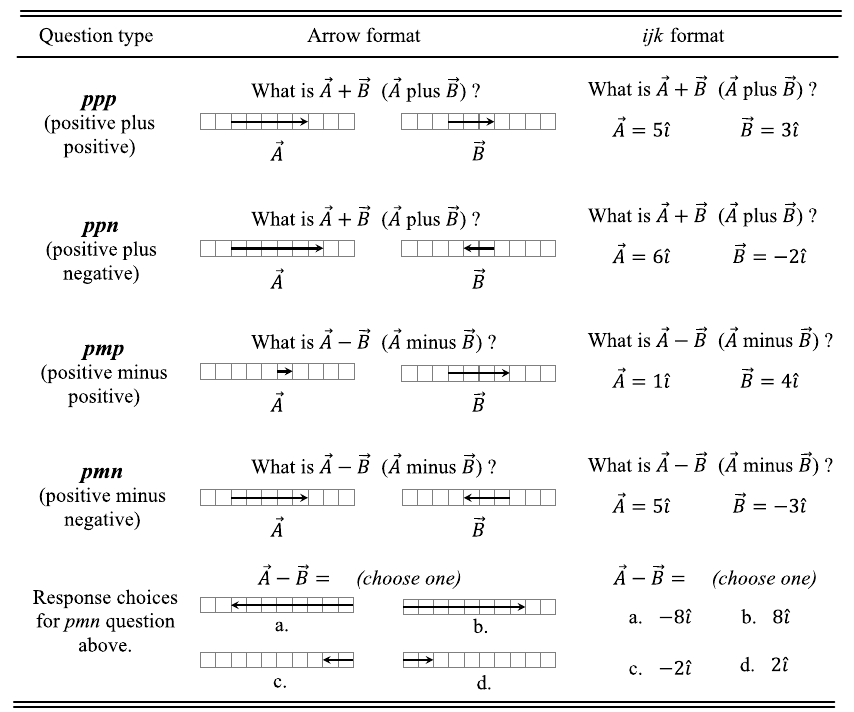
FIG. 1. Examples of one-dimensional questions in arrow and ijk